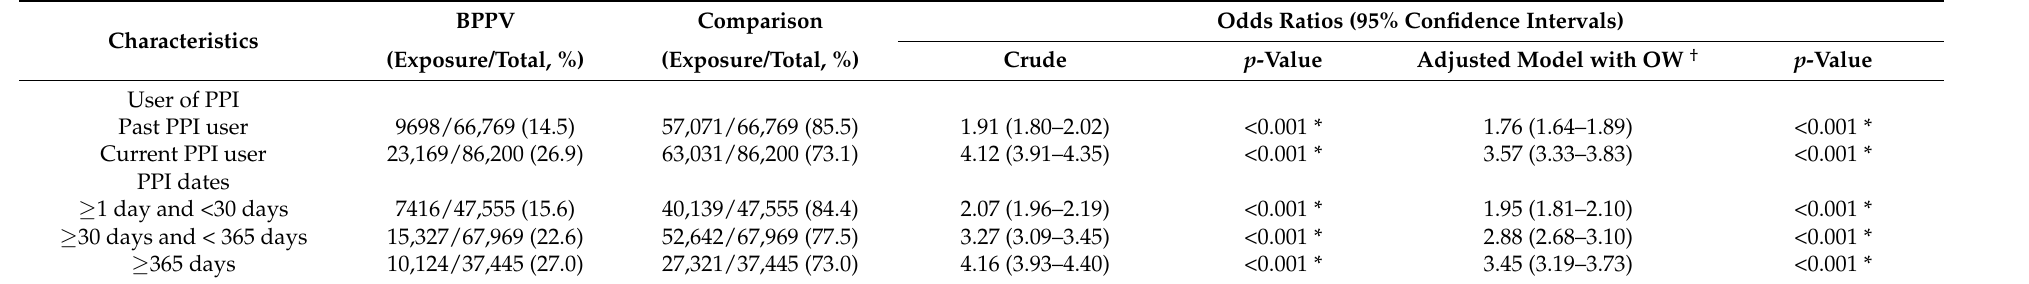
Table 2. Odds ratios (95% confidence interval) of PPI prescription history and PPI prescription dates for